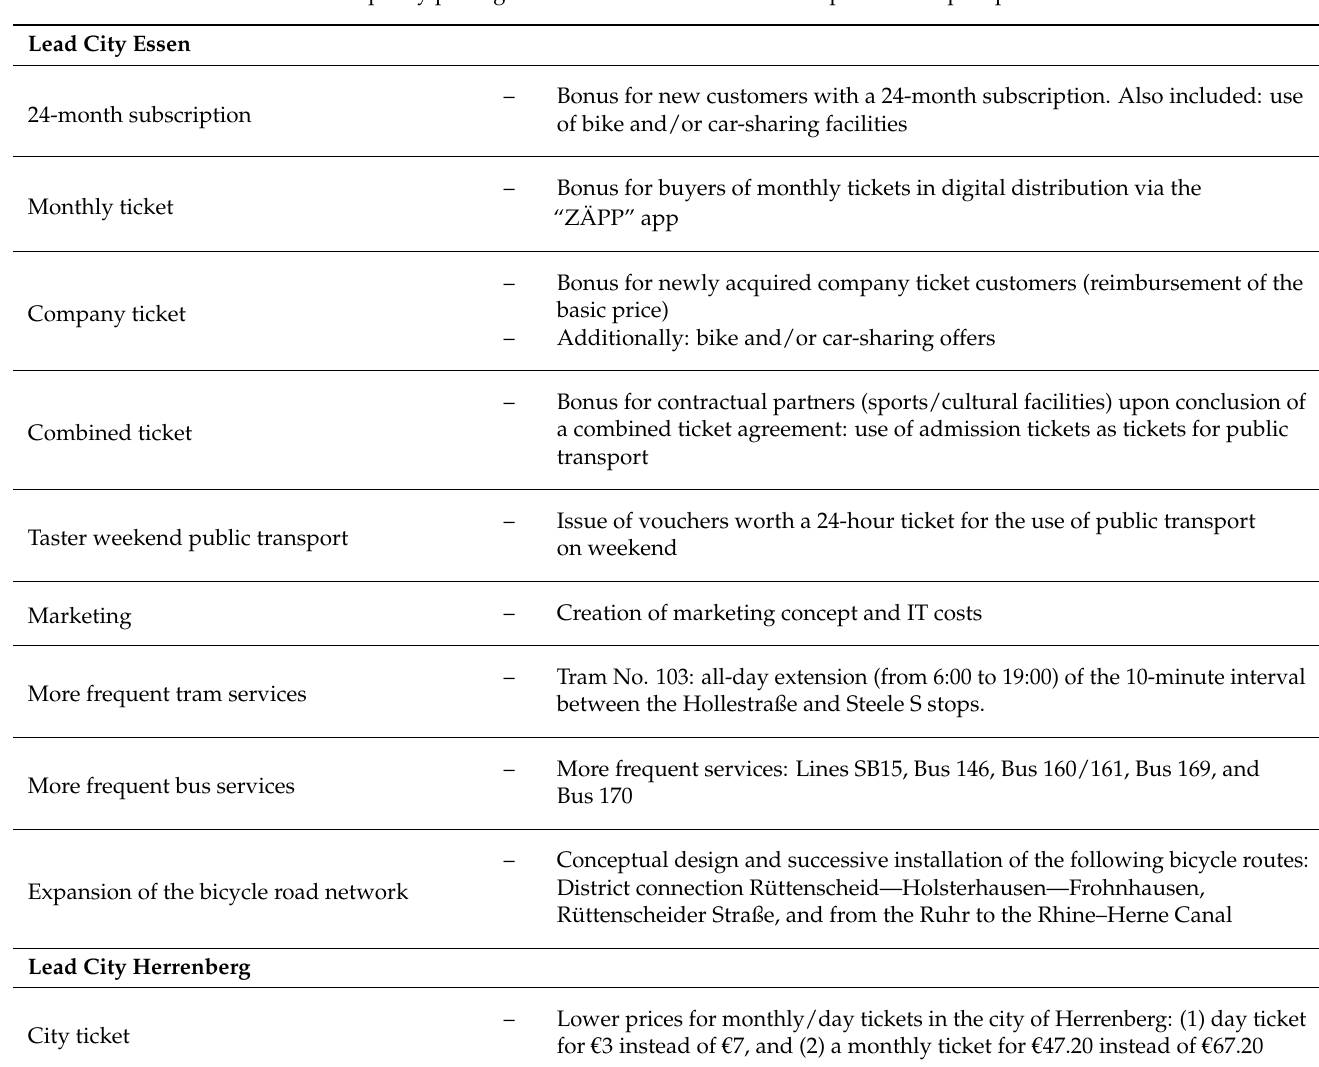
Table 6. Final policy packages related to the core measure of public transport